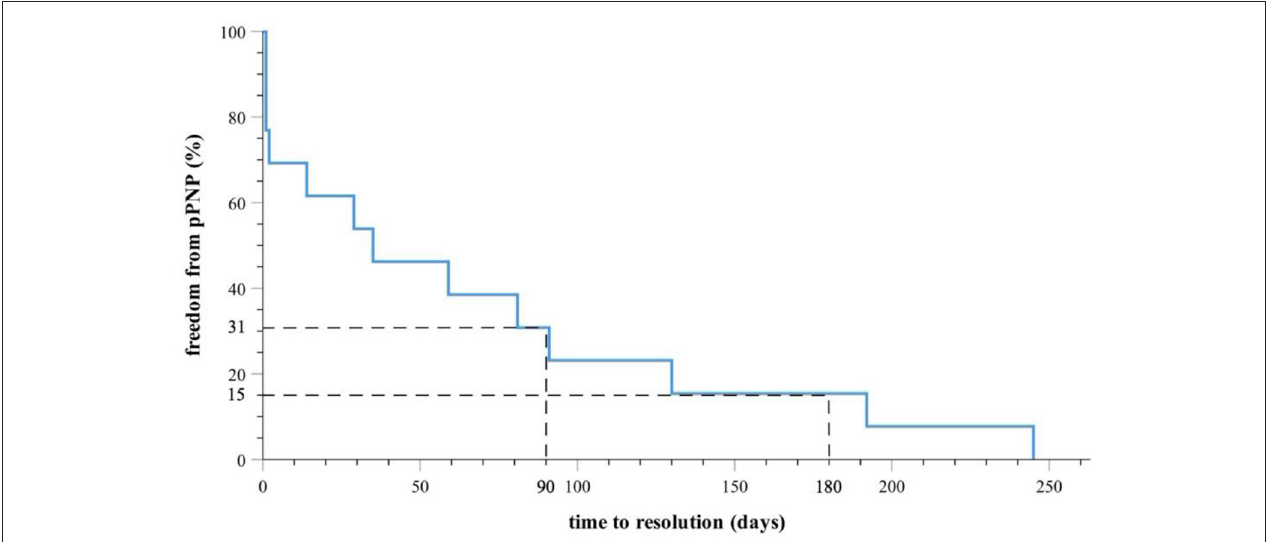
FIGURE 2 | Kaplan-Meier-Survival-Curve indicates complete PNP recovery in all patients during follow-up. Thirty-one percentage of the patients suffered from ntPNP 90 days and 15% of the patients suffered from ntPNP 180 days after index procedure.